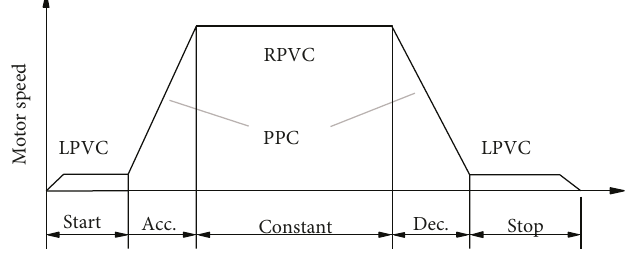
Figure 3: Speed regulation process in a working